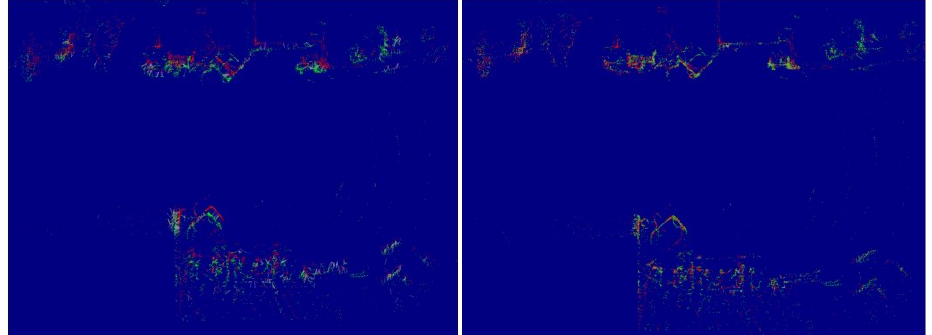
Figure 4. The first and last state of the point clouds when the SMS makes an estimation of the relative position between both. The red point cloud remains stationary, while the green one moves to reduce